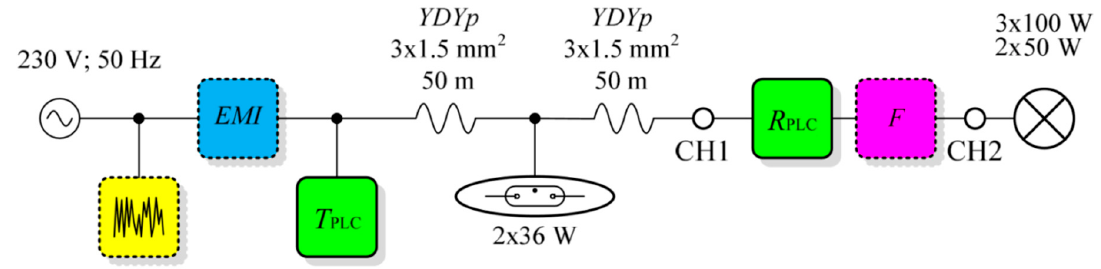
Figure 12. Connection schematic of the model with an EMI filter and an additional receiver connected in the middle of the line (without an F filter)—Variant 2.